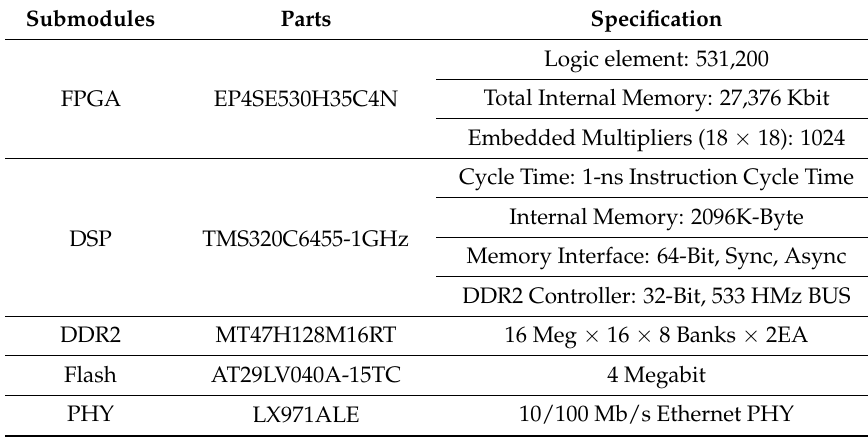
Figure 6. Photograph of the developed data-logging platform. IO: input output, CPLD: complex programmable logic device, ADC: analog to digital converter, DSP: digital signal processor, DDR2: double data rate two, FPGA: field programmable gate array. Table 3. Specifications of the developed data-logging